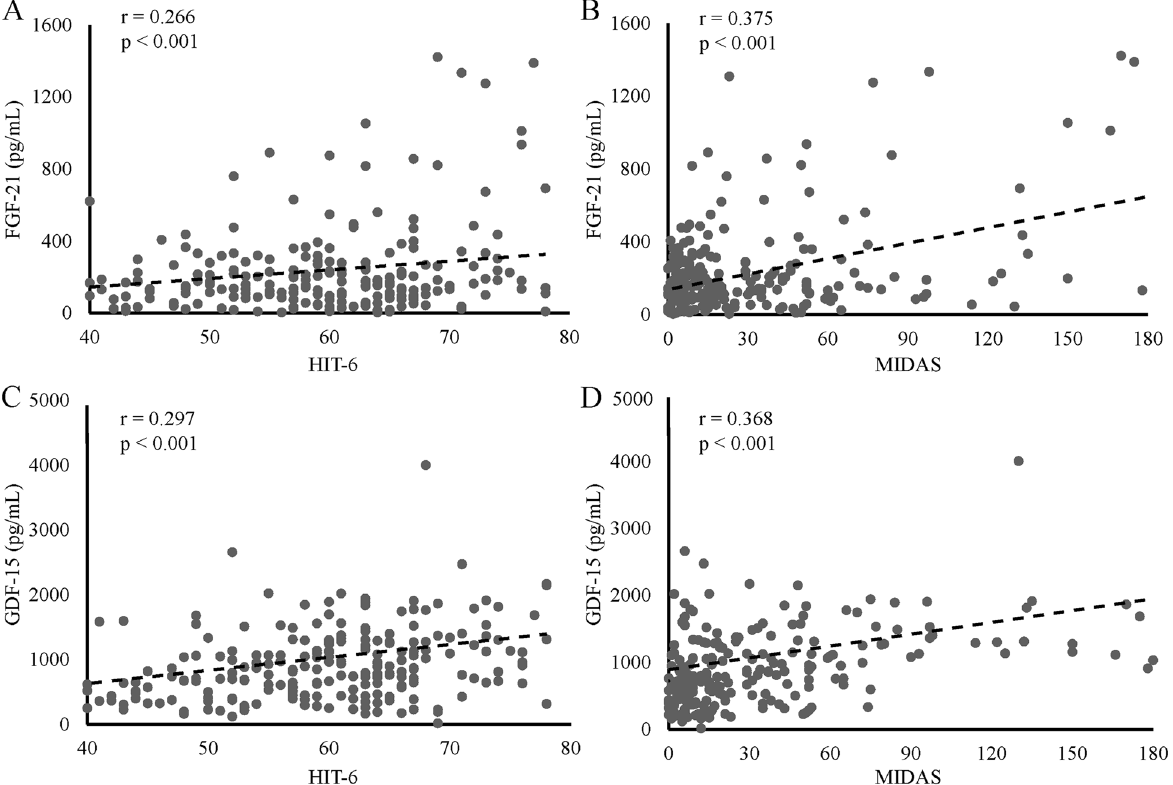
Fig. 3 Correlation between cytokines and clinical variables in migraineurs. A FGF-21 and HIT-6. B FGF-21 and MIDAS. C GDF-15 and HIT-6. D GDF-15 and MIDAS. HIT-6: 6-item Headache Impact Test; MIDAS: Migraine Disability